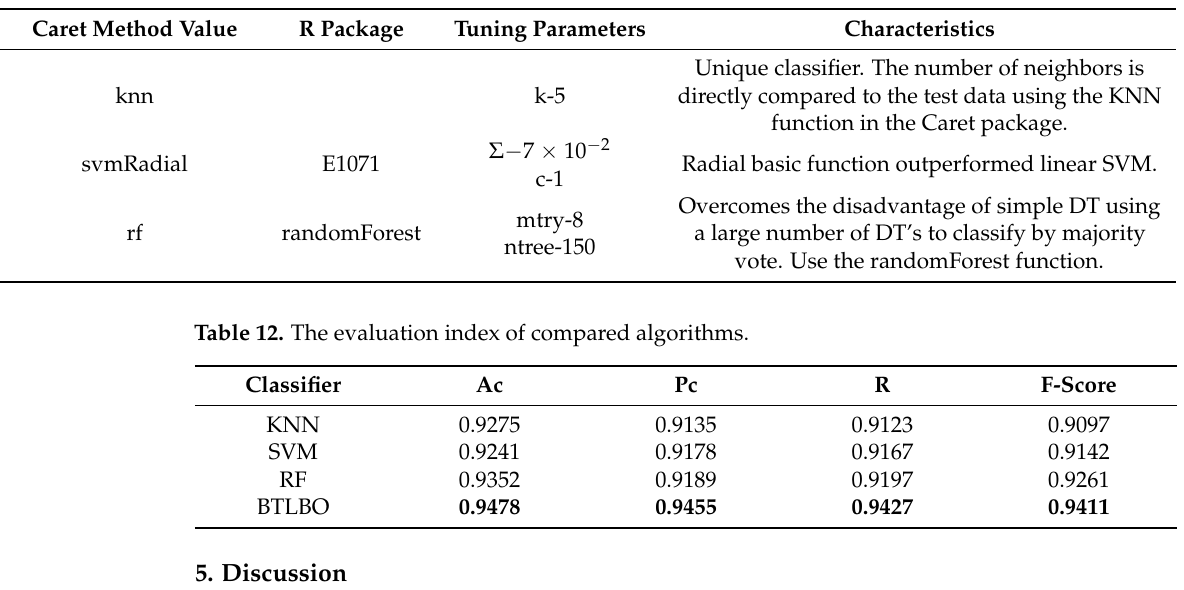
Table 11. Configuration parameters and characteristics of the classifier models.